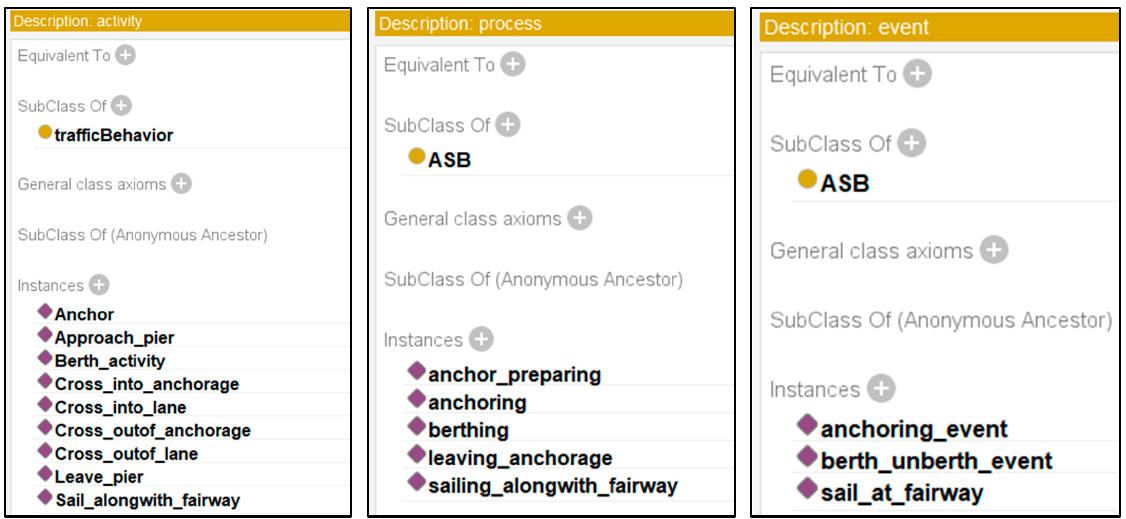
Figure 5. Results of ship semantic behavior in port water traffic areas.